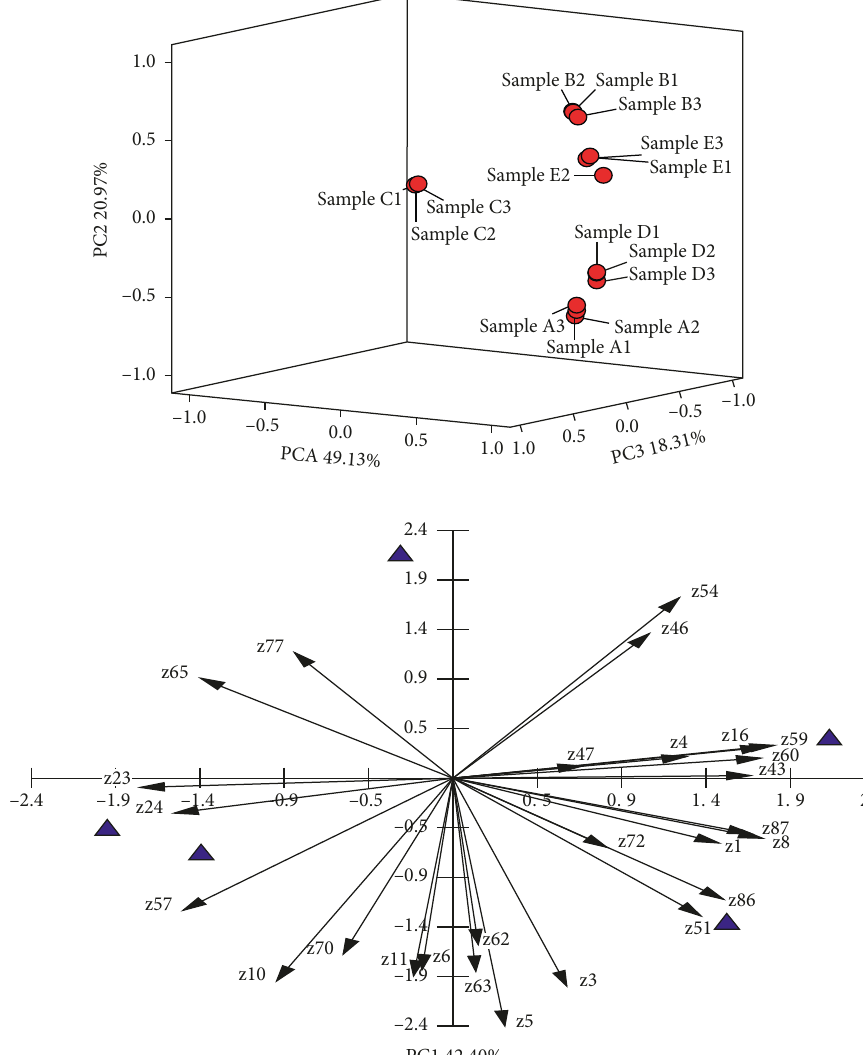
Figure 2: The loading plot to the projection was based on 27 volatile compounds. The first two principal components (PC1 and PC2) explain 42.40% and 28.56% of the total variance across the data collection, respectively. 27 VOCs (z1, z3, z4, z5, z6, z8, z10, z11, z16, z28, z31, z33, z37, z40, z43, z45, z46, z48, z49, z51, z55, z57, z65, z66, z67, z77, z86, and z87) were selected by significant comparison and established three homogeneous groups (HG) formed at p ≤ 0 . 05 statistical level to apply principal component analysis (PCA) after that the data were square- root transformed (sample A, only salt; sample B, Chinese prickly ash; sample C, Amomum tsao-ko ; sample D, cumin; sample E,